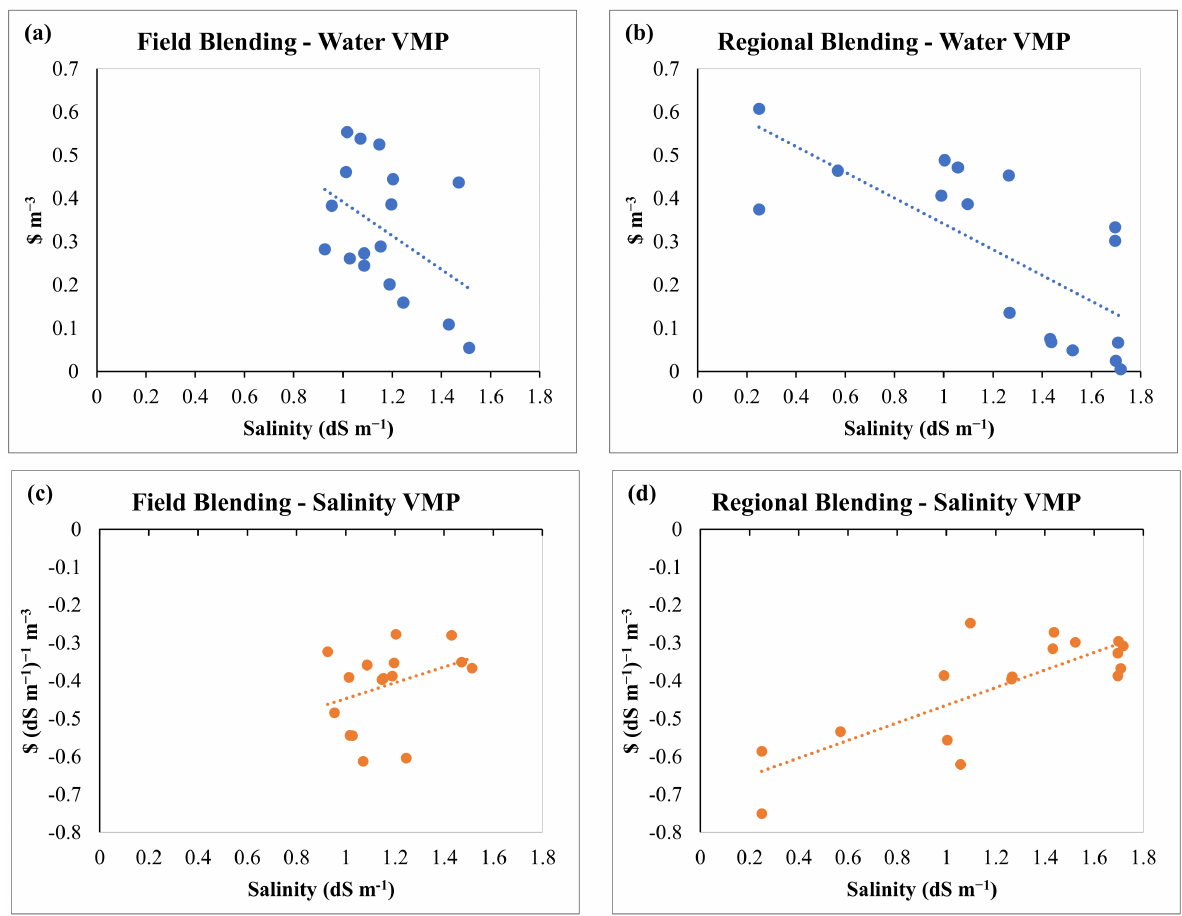
Figure 7. Regional VMPs of irrigation water and its salinity plotted against regional average salinities under the field blending and regional blending